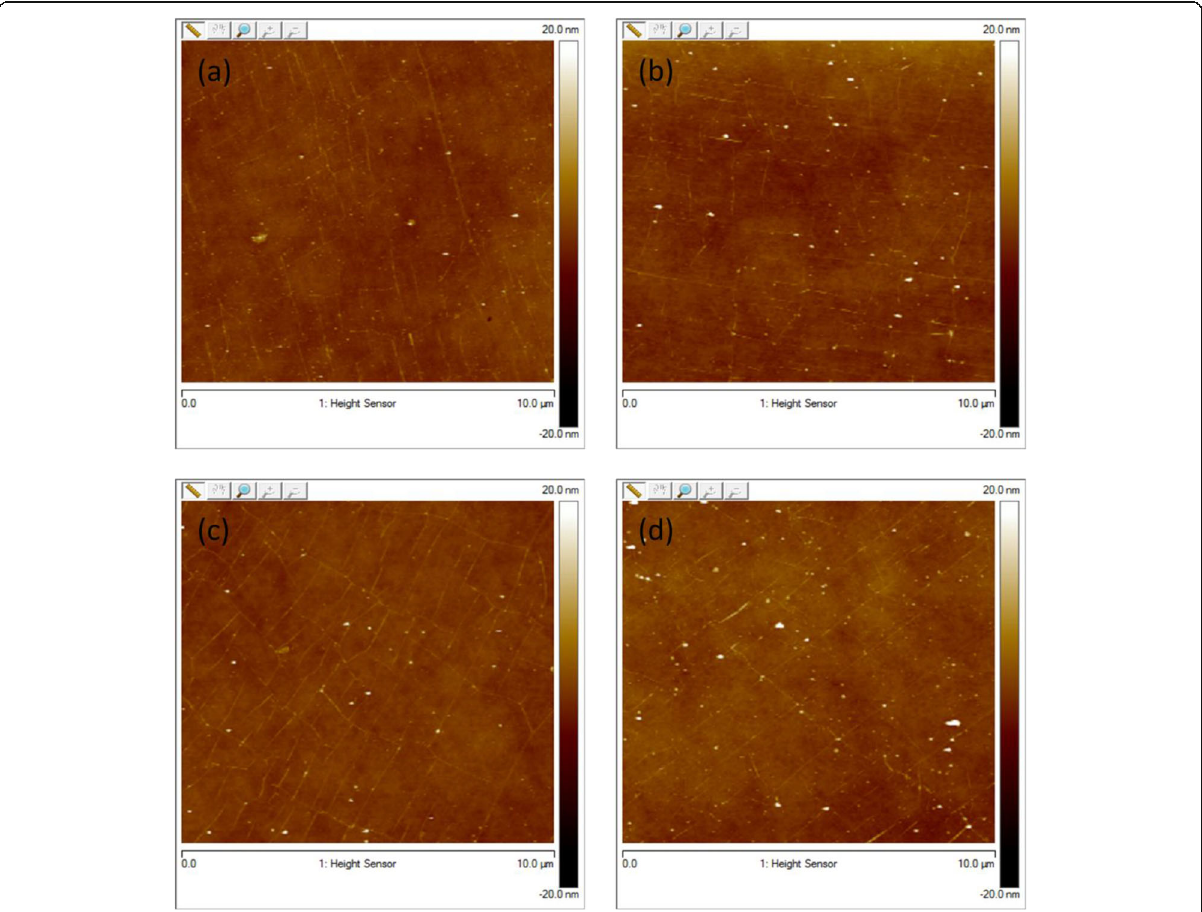
Fig. 5 AFM spectrum of a PMMA coated transfer at room temperature (RMS = 1.03 nm) and b – d PMMA transferred sample baked at 100 °C (RMS = 1.51 nm), 150 °C (RMS = 1.49 nm), and 200 °C (RMS = 1.72 nm),